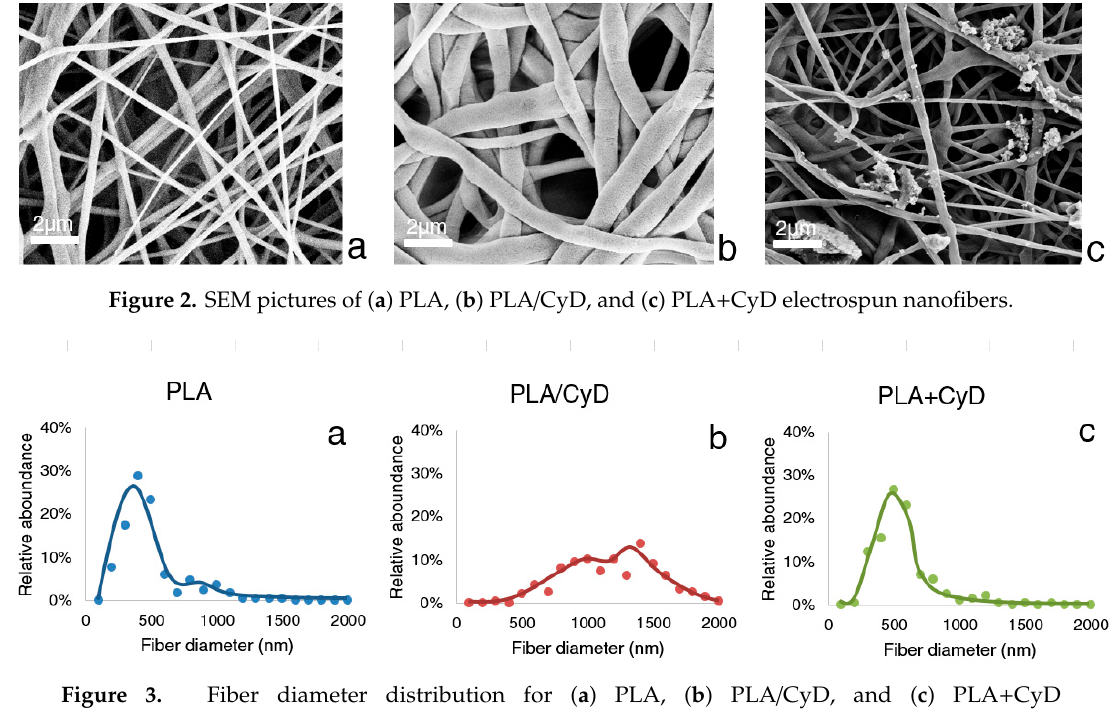
Table 1. Composition and characterization of the electrospun filter media.